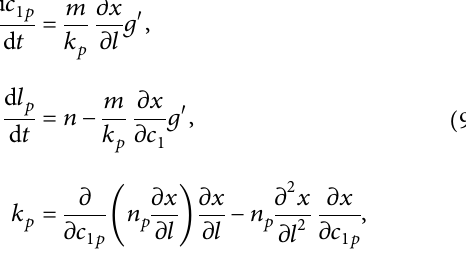
Figure 2: For n � 0 . 0001 , ε � 0 . 000000000000000001 ,A and e � 0 . 001. (a) Poincare map, (b) Poincare surface of section, (c) Lyapunov exponent, and (d) time